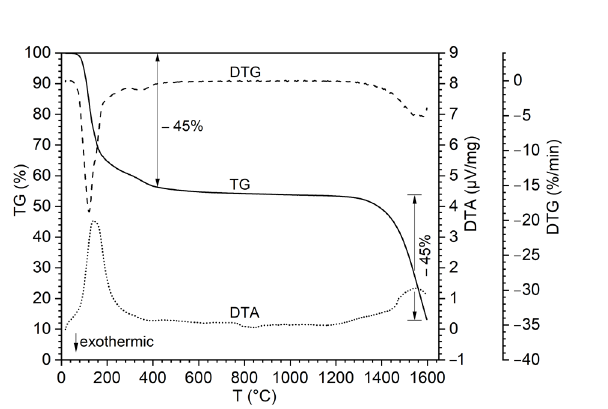
Figure 2. TG, DTG and DTA curves of a powder mixture with molar ratio B 2 O 3 /C = 2:1.